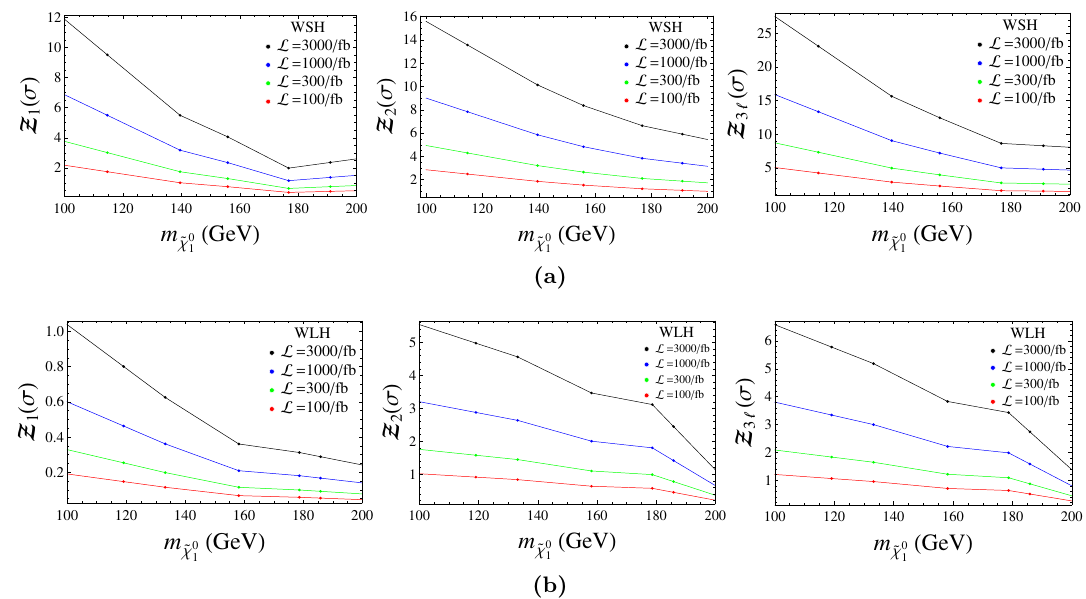
Figure 8. Statistical signi(cid:12)cances obtained for the signals S 1 (left column) and S 2 (central column) and their combination, S 3 ‘ , (right column) for each of the (cid:12)ve BPs per scenario. See text for further